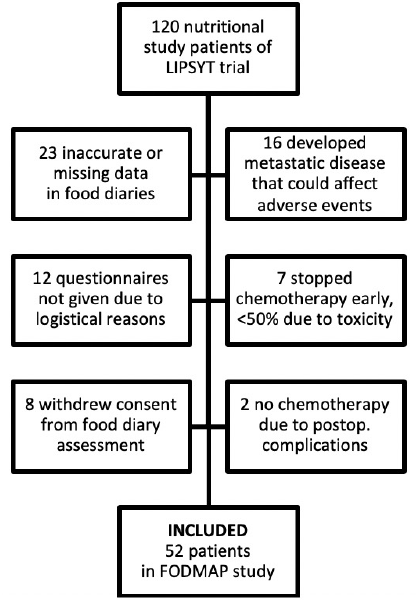
Figure 1. Flowchart showing the 120 patients originally included in the LIPSYT (Liitännäishoito: Paksu- ja PeräsuoliSYöpäTutkimus, Finnish acronym) nutritional intervention study and the 52 patients examined in the FODMAP (fermentable, oligo-, di-, mono-saccharides and polyols) study. Reasons for exclusion are provided.